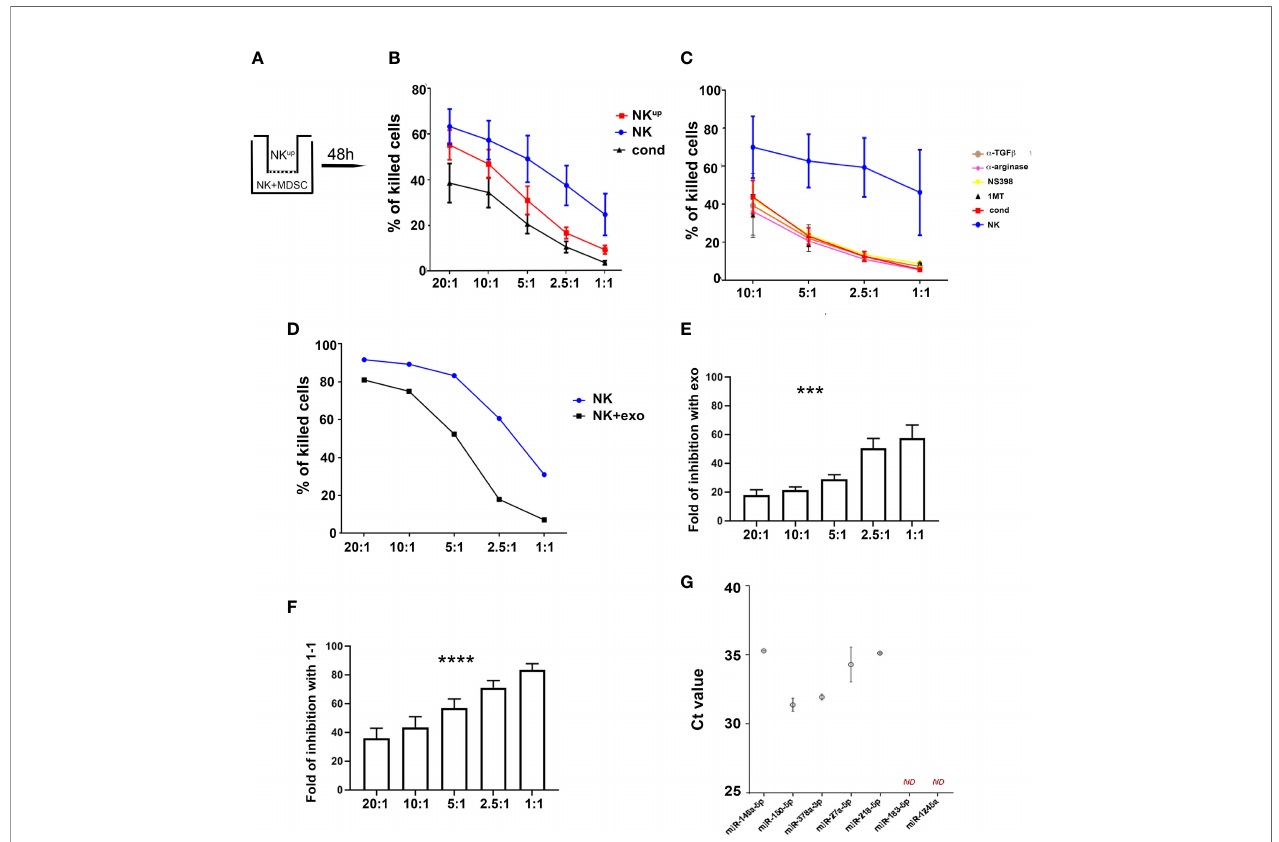
FIGURE 4 | PMN-MDSC-mediated inhibitory mechanisms of NK cell function. (A – C) Activated NK cells were cultured alone (NK) or with PMN-MDSC (ratio 1/1) under cell-to-cell contact or transwell (NK up ) condition. After 48h of co-culture, PMN-MDSC were depleted in the 1/1 condition and the resulting NK cells were used as effector cells (cond.) in the functional assays. (A) Schematic culture conditions. (B) Percentages (mean ± SEM) of killed NALM-18 target cells at different E/T ratios in NK cells cultured alone (blue), in cell-to-cell contact with PMN-MDSC (black) and in the transwell chamber (red) (n = 6). (C) Percentages of mean ± SEM of killed NALM-18 target cells by NK cells cultured alone or in the presence of PMN-MDSC either in the absence or in the presence of indicated inhibitors and blocking mAbs (n = 3). (D) Activated NK cells were incubated with 20 ug of exo-derived PMN-MDSC. After 48h their cytolytic potential was assessed against NALM-18 cell line. Percentages of mean ± SEM of killed NALM-18 target cells at different E/T ratios. One representative experiment. (E) Fold of inhibition of NK cell killing capability upon incubation with 20ug of PMN-MDSC derived exosomes at different E/T ratios (n = 4). (F) Fold of inhibition of NK cell killing capability upon co-culturing with PMN-MDSC at different E/T ratios (n = 9). (G) Expression of immuno-modulatory miRNAs in lung cancer PMN-MDSC-derived exosomes. Real time PCR analysis for the indicated miRNAs in lung cancer PMN-MDSC exosomes. Threshold cycle (Ct) values for each miRNA are reported. Bars indicate SD (n = 2). ND, Non Detected. ***p ≤ 0.0005; ****p ≤